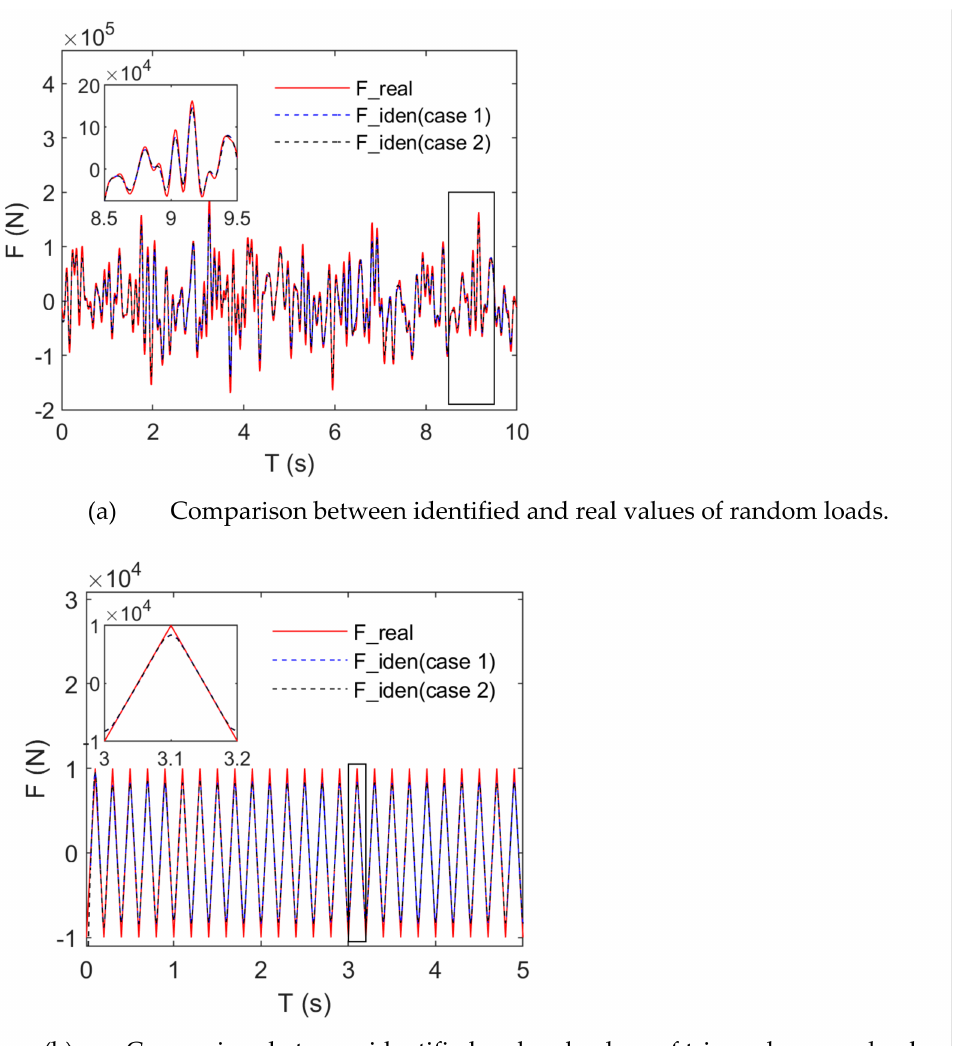
Figure 11. Comparison between identified and real values under noise-free